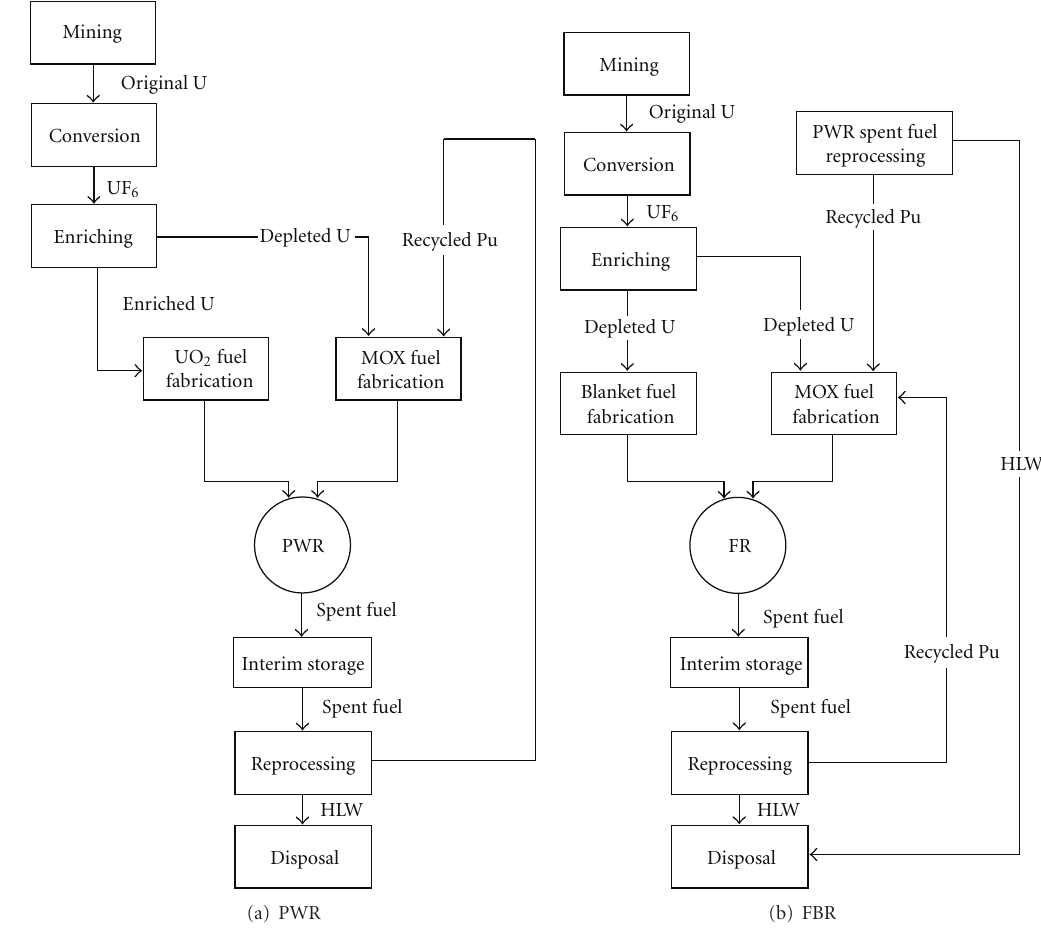
Figure 2: The mass flow of heavy metal in the closed fuel